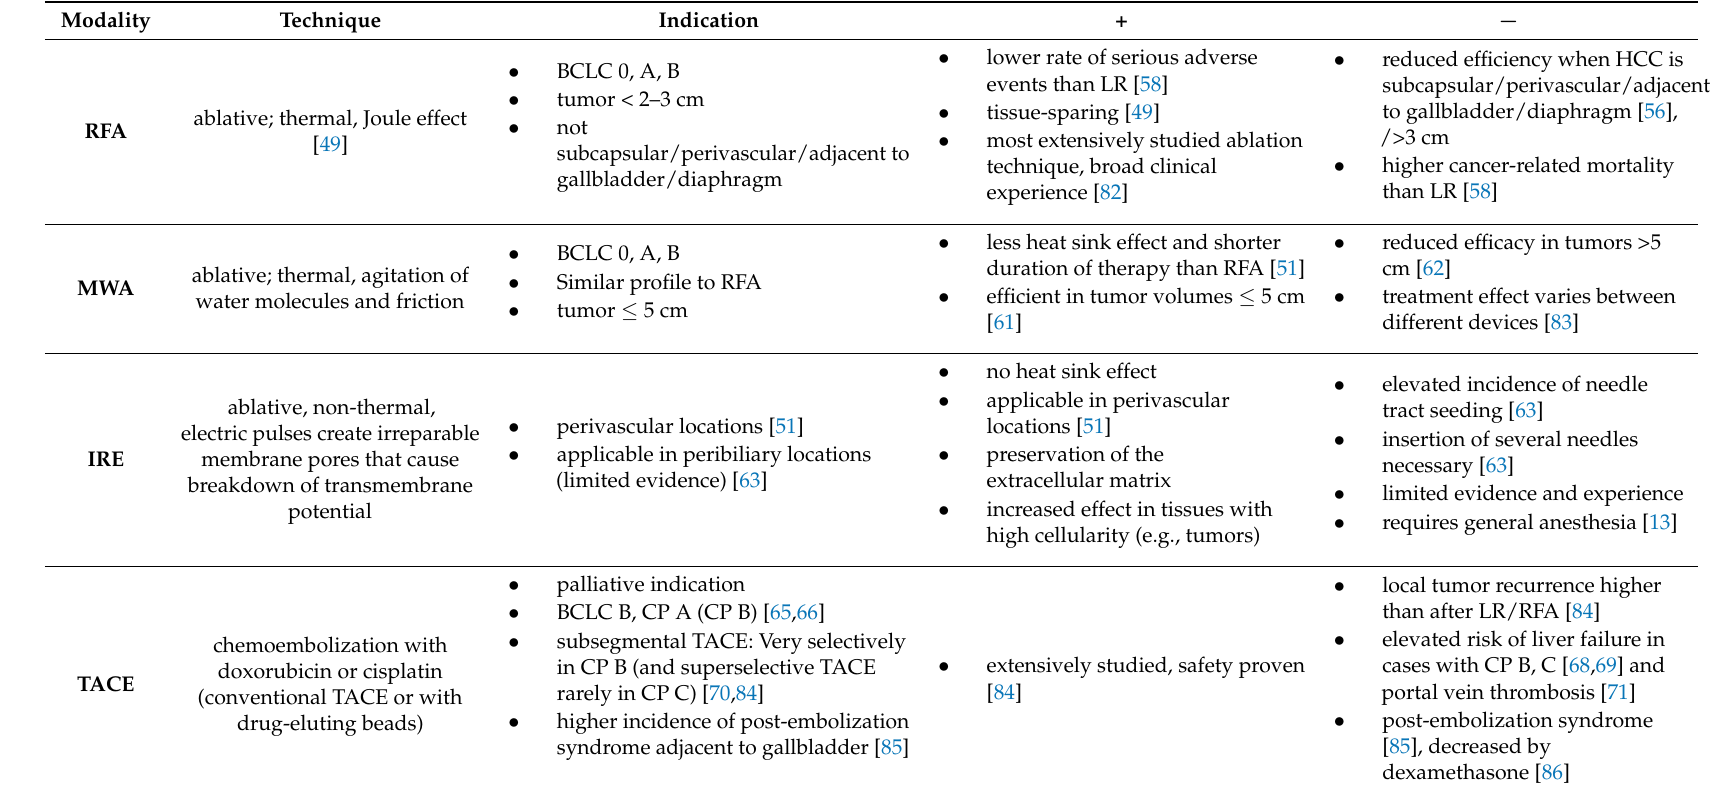
Table 2. Overview of loco-regional treatment strategies for